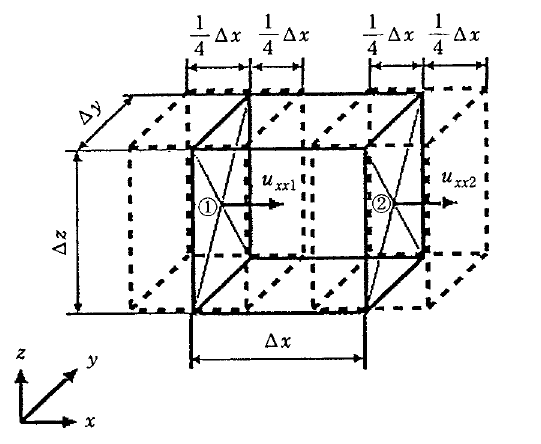
Fig. 4 . Stress computational domain Fig. 5 . Stress computational